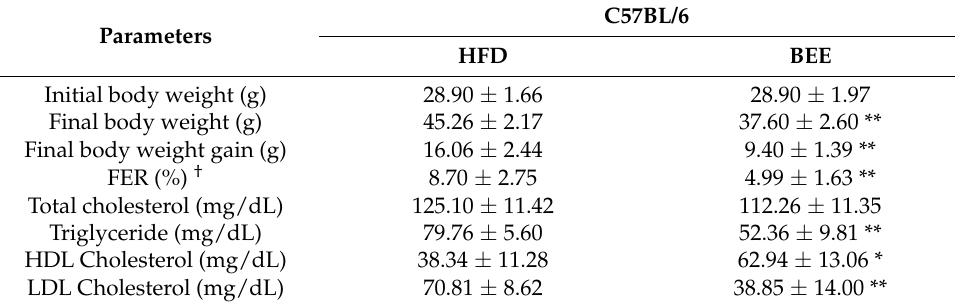
Table 1. Effects of BEE treatment on various parameters in C57BL/6.